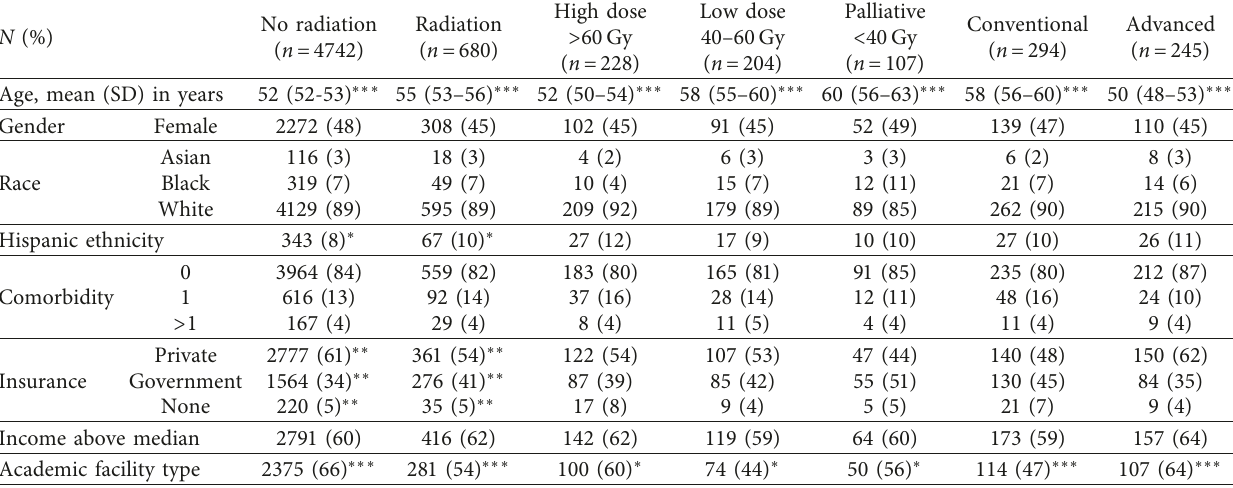
Table 1: Patient characteristics.